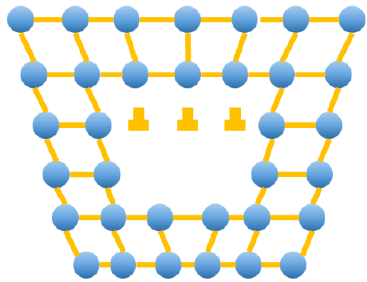
Figure 19. Ductile dislocation piling up.